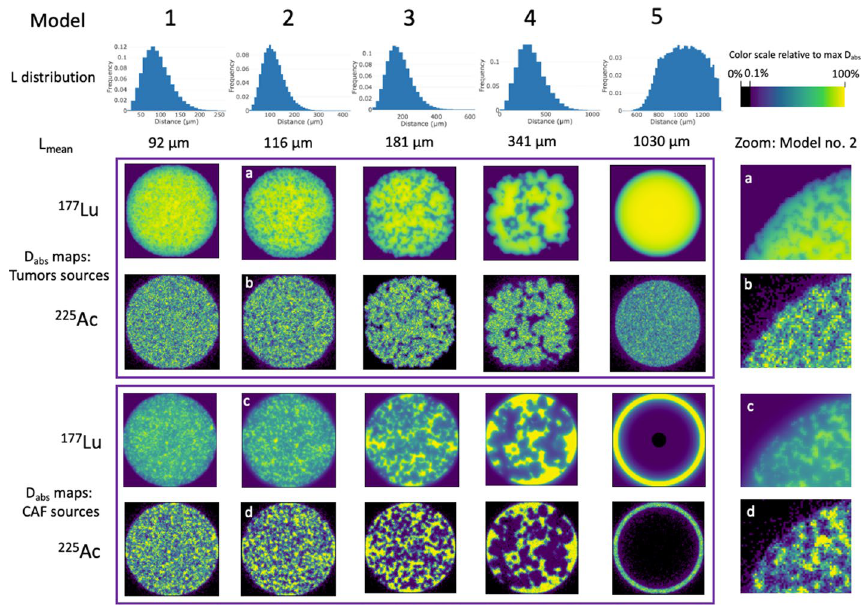
Fig. 4 Representative slices of the five models with their associated L mean (left column: grey are tumor cells, white are CAFs) and associated D abs maps with tumor cells and CAFs as sources for 177 Lu and 225 Ac. Magnifications of the upper left corner of model 2 are provided to show the differences in stochastic noise between the radionuclides (right column)